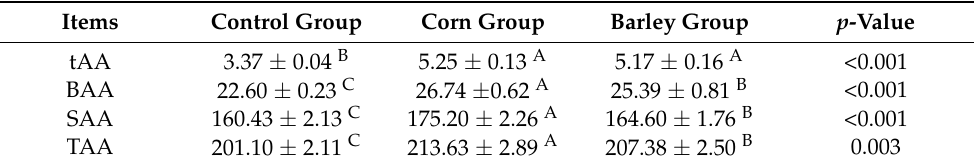
Table 9. Effects of different carbohydrate source diets on composition of free amino acids 521 (mg/100 g) in beef.